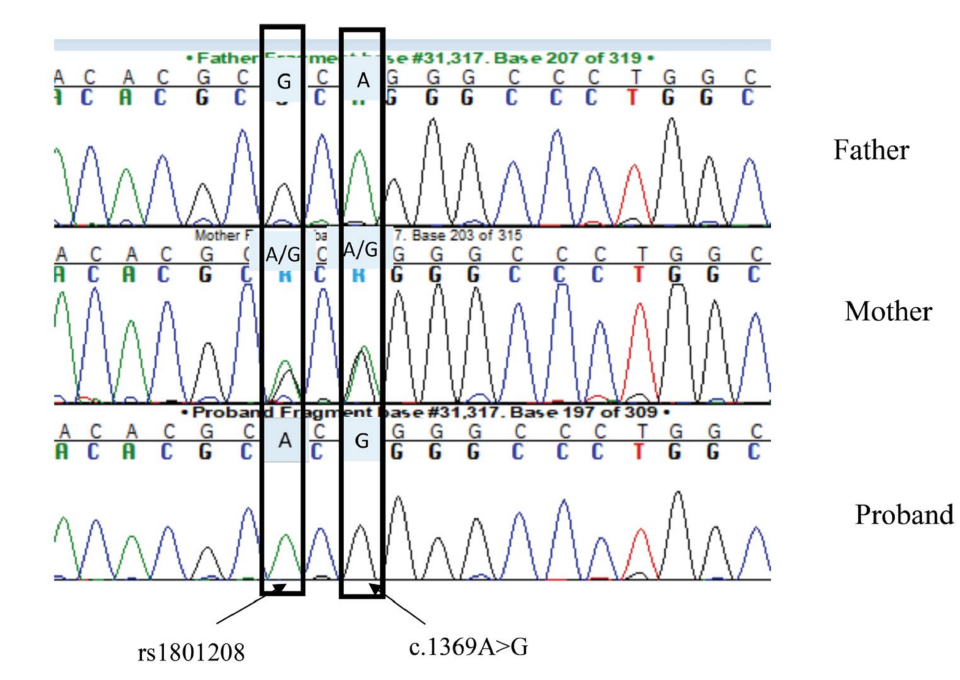
Figure 1. Segregation of WFS1 novel missense variant c.1369A>G; p.Arg457Gly and rs1801208 in family pedigree. Electopherogram shows that proband was the missense variant and SNP were detected in a homozygous state in the proband and in a heterozygous state in the mother. The father was wild type for both